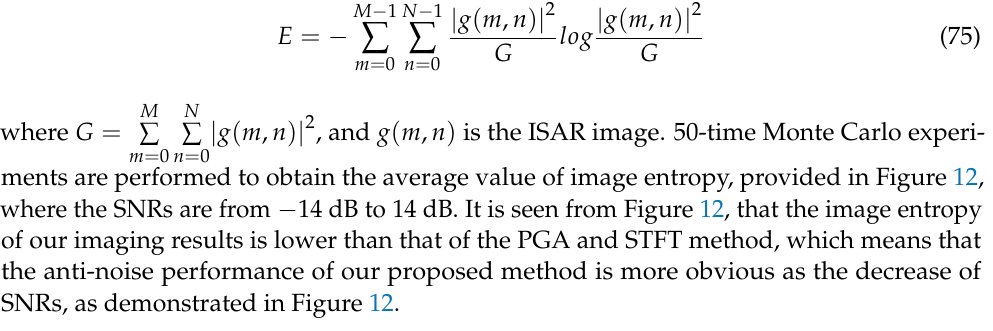
( b ) Figure 13. Destroyer model. ( a ) Photograph of the destroyer. ( b ) 3-D CAD model of the destroyer.